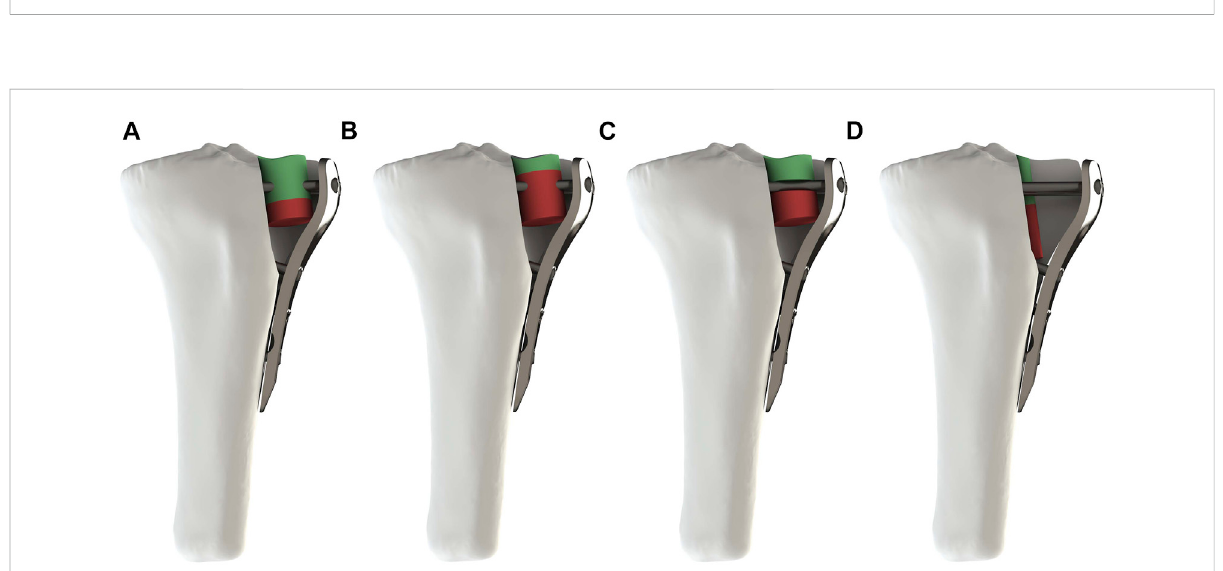
FIGURE 1 AgeometricmodelofSchatzkerIIfracturewaspresentedusingSubtypeCasanexample. (A) Overall3Dviewoftheworkingconditions. (B) The frontal view of the tibial, shows the depressed fragment, fi ller, screw, plate, and tibial shaft. (C) The mirror view of (A) shows the separated fragment.